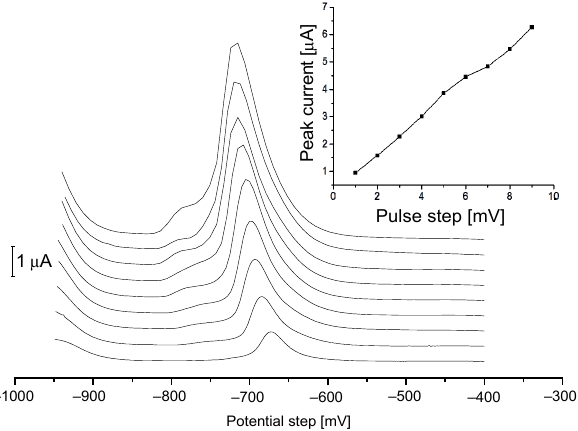
Figure 3. Potential pulse step (Es) dependence on peak current for 1–9 mV. Instrumental parameters: Δ E = 30 mV, tw, tp = 10 ms. Stirring rate, 500 rpm.